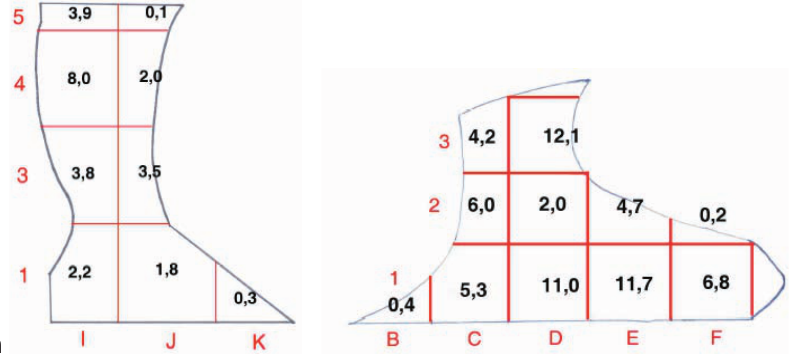
Fig. 5. Perforator detection averages in the cervical (a) and abdominal (b) regions